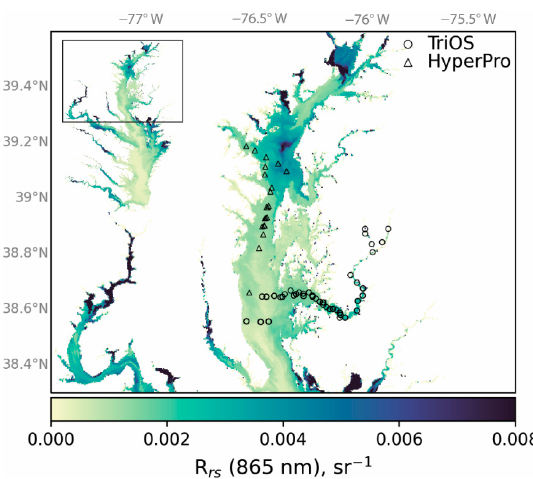
Figure 1. Study region of Chesapeake Bay, United States depicting R rs at 865 nm (NIR wavelength) captured on 23 March 2019 processed by the C2RCC atmospheric correction algorithm. In situ observation locations as collected by hyperspectral TriOS (circles) and HyperPro (triangles) radi- ometers.